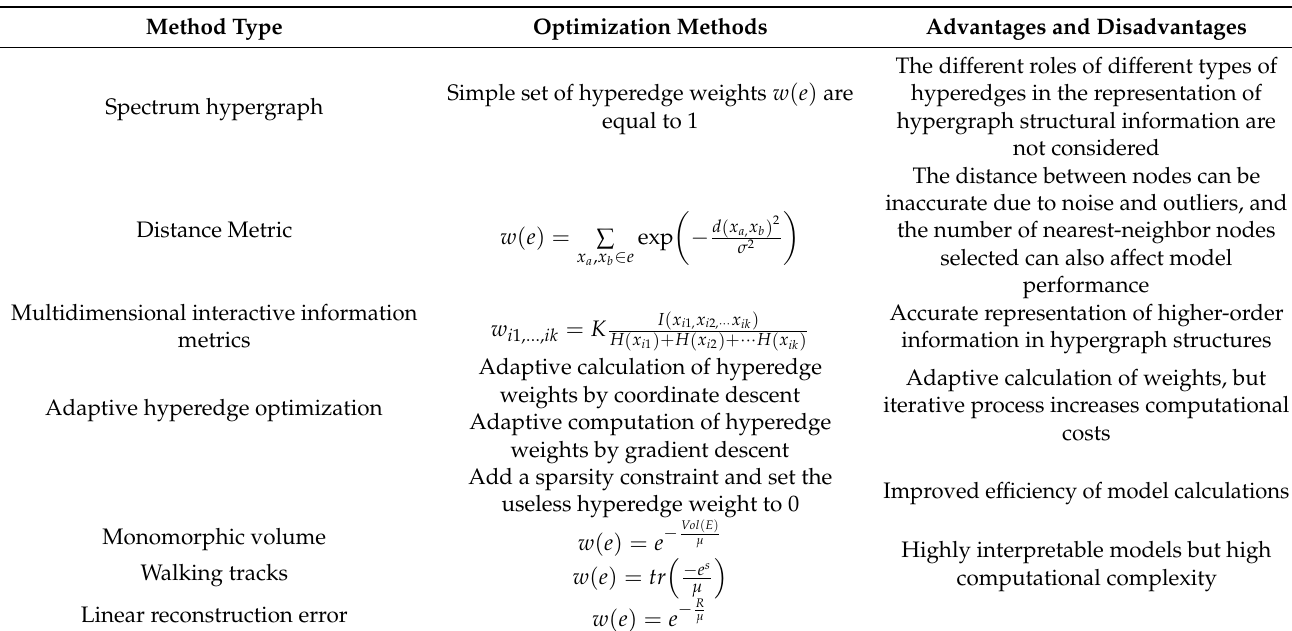
Table 4. Hyperedge weight optimization